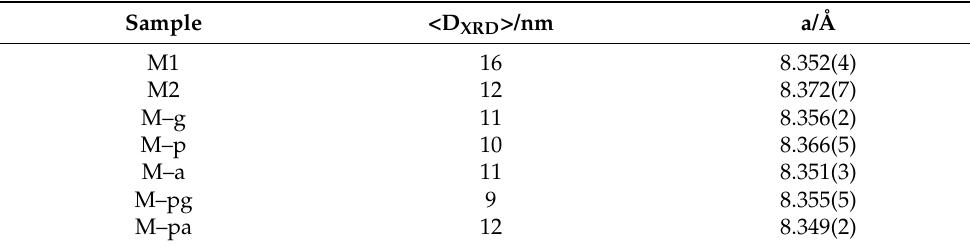
Table 2. Mean particle sizes (<D XRD >) and cell parameters (a) obtained from XRD. Sample